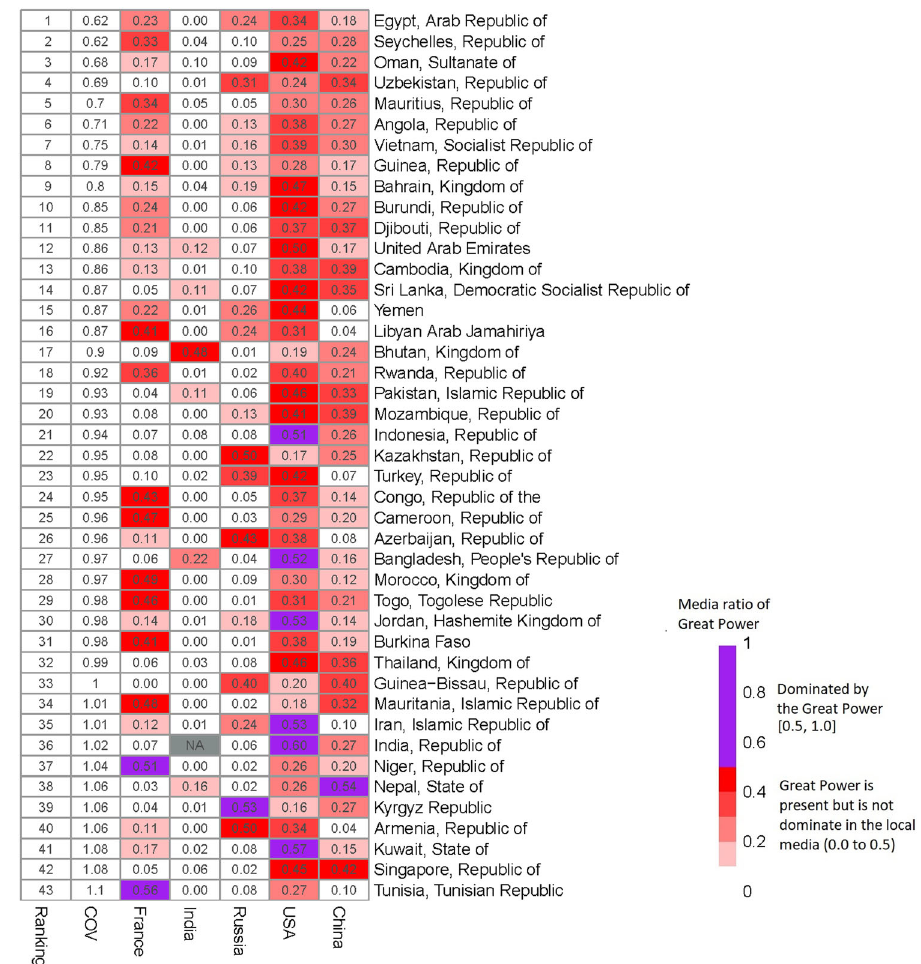
Fig. 1 Coef fi cient of variance and media ratio for great powers for the most competitive countries in Asia and Africa (ranking 1 to 43 out of 88 countries).